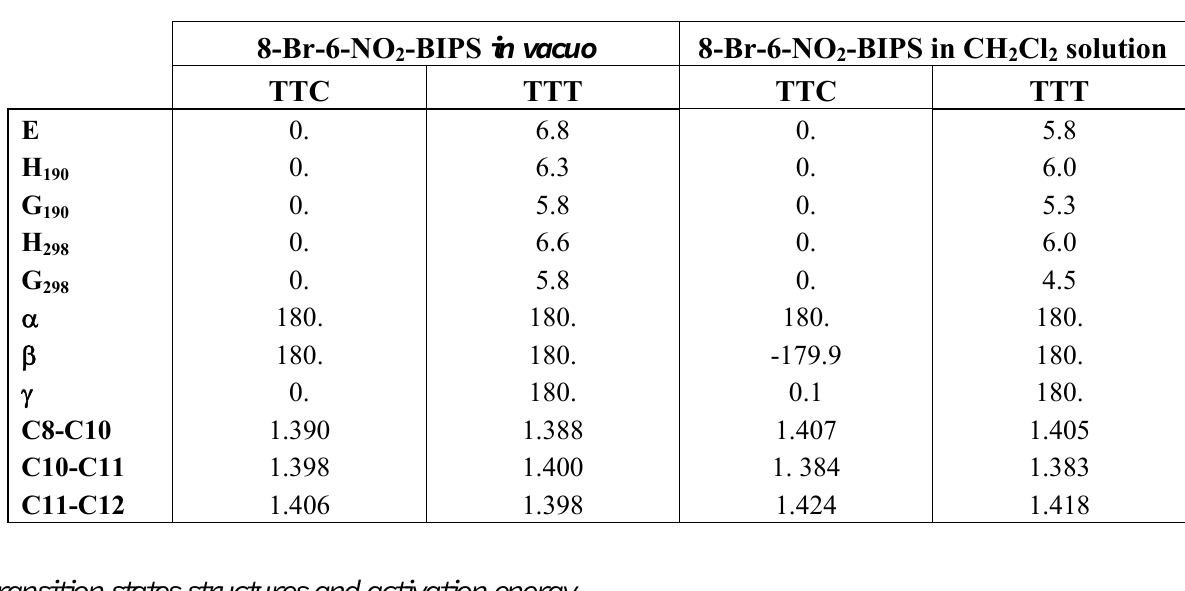
Table 1. Relative energies (kJ ⋅ mol -1 ), relevant torsional angles (degrees) and bond lengths (Å) of 8-bromo-6-nitro-BIPS (TTC and TTT isomers) in vacuo and in methylene chloride solution at 190 K and 298 K.